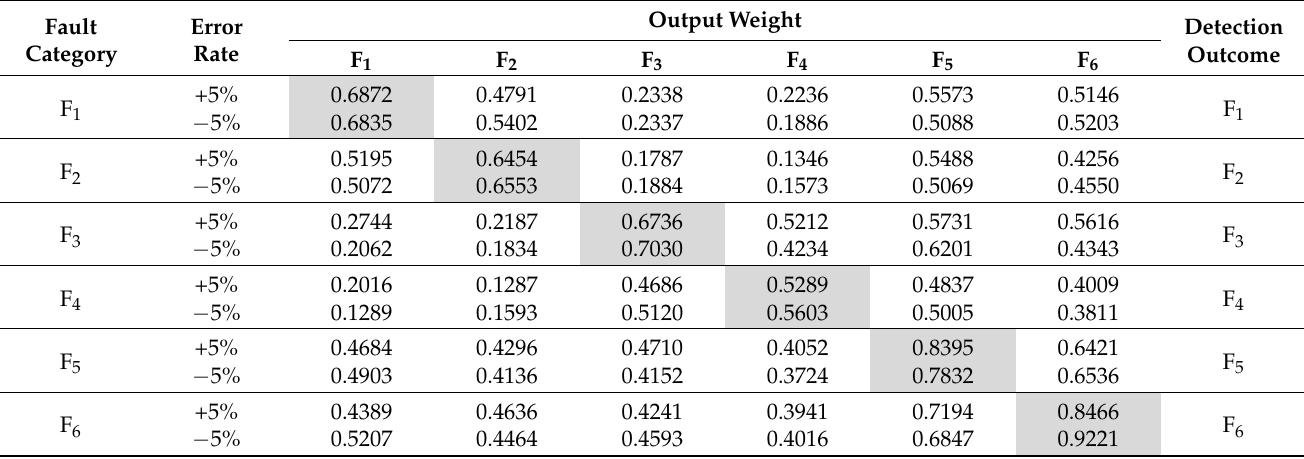
Table 10. Detection outcomes of the inverter at 120 Hz with a ± 5% error